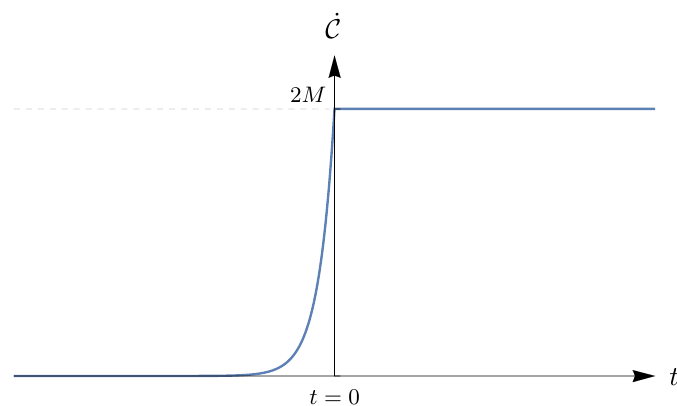
Figure 3 . Growth rate _ C of holographic complexity as a function of tortoise time t , using the CA prescription, for classical gravitational collapse. Following an exponential onset, holographic complexity grows linearly with